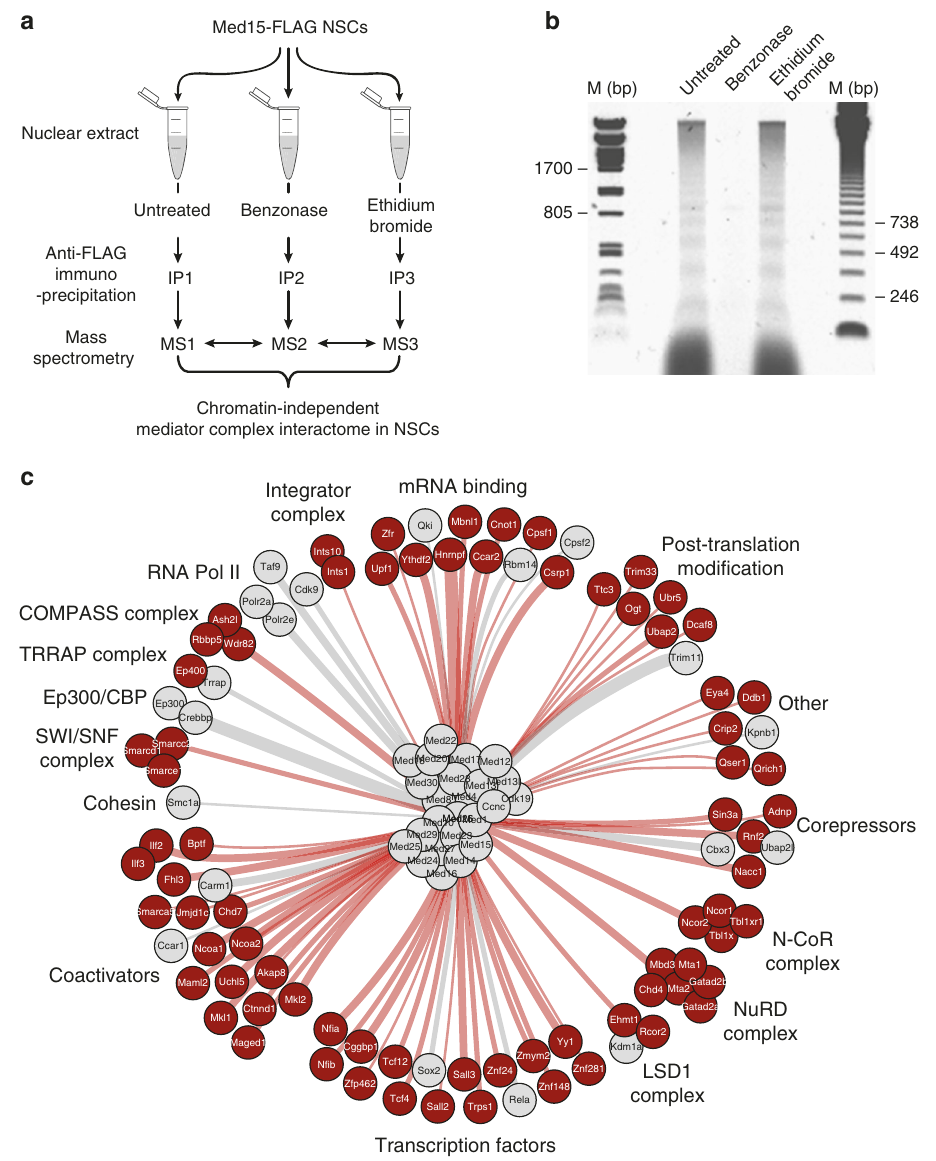
Fig. 1 Mediator complex interactome in neural stem cells. a Schematic representation of Mediator complex puri fi cations from neural stem cells (NSCs) expressing Med15-FLAG. Mass spectrometry results of the three conditions were compared to select proteins that do not decrease in abundance upon treatments as chromatin-independent Mediator complex interactors. IP immunoprecipitation, MS Mass spectrometry. b Agarose gel with DNA from untreated NSC nuclear extract or nuclear extract treated with Benzonase or Ethidium Bromide, as indicated. DNA size markers (M) are indicated. Source data are provided as a Source Data fi le. c Interactome of the Mediator complex in NSCs. Novel Mediator interaction partners are in red, known Mediator interaction partners are in grey. Thickness of the edges gives an indication of the relative molar protein quantity observed in the puri fi ed Mediator complex